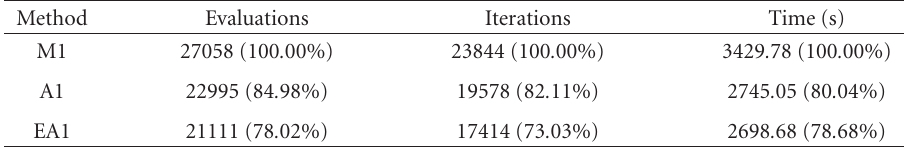
Table 4 . 3 . Results for dimensions from 16 to 45 (240